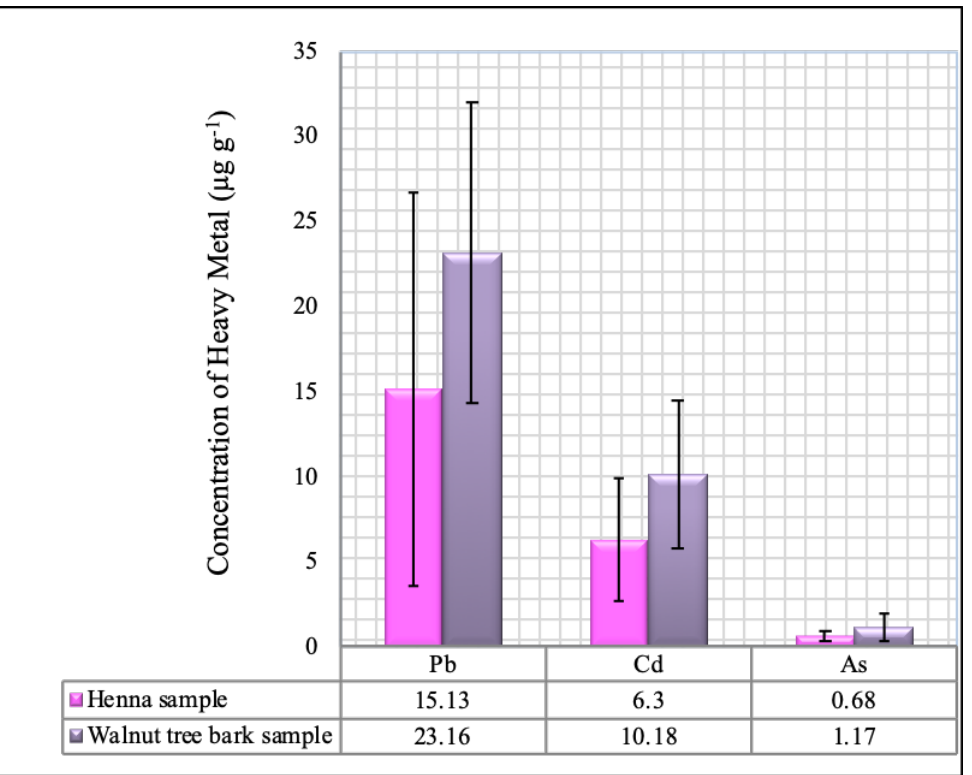
Figure 4. Comparison of mean concentration levels of Pb, Cd and As in henna and walnut tree bark samples. Table 8. Comparative between concentration levels of Pb, Cd and As in henna and walnut tree bark samples. Concentration of Heavy Metal (µg g −1 ) Element